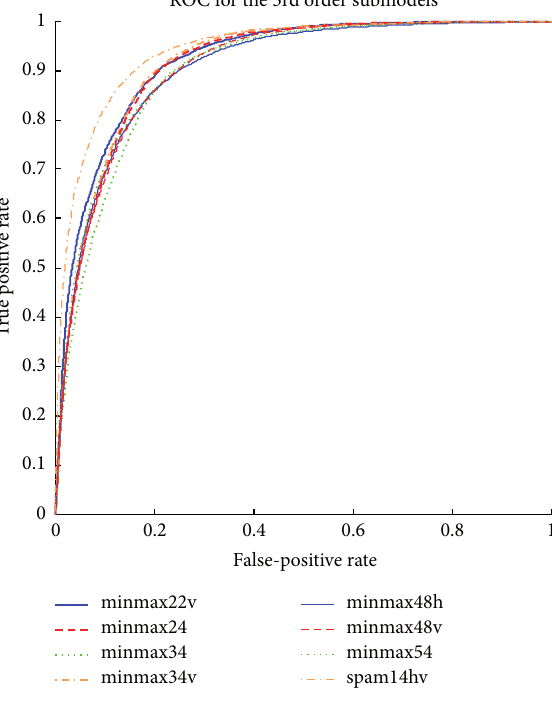
Figure 3: ROC curves for first order features.